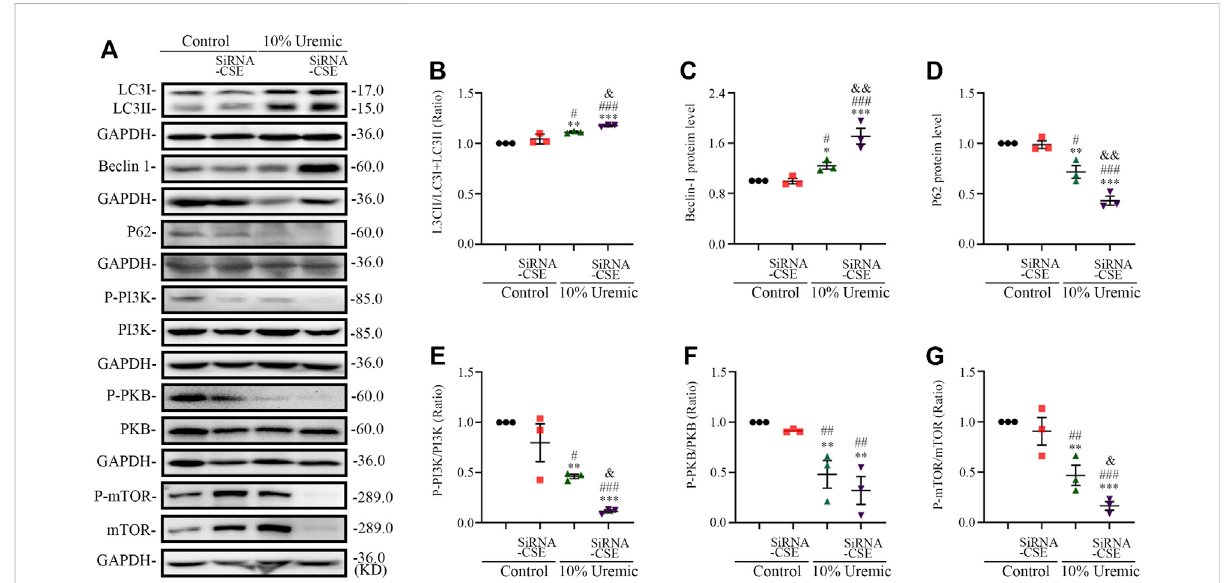
FIGURE 6 Endogenous H 2 S de fi ciency exacerbates uremic serum-induced overactive autophagy in H9C2 cardiomyocytes. (A) Representative Western blot images of LC3, becline-1, P62, p-PI3K/PI3K, p-PKB/PKB, and p-mTOR/mTOR in four groups of H9C2 cardiomyocytes. (B – D) Quanti fi cation of the LC3II/LC3 (I + II) ratio, becline-1 protein levels, and p62 protein levels in the four groups of H9C2 cardiomyocytes, with n = 3 per group. (E – G) Quanti fi cation of p-PI3K/PI3K, p-PKB/PKB, and p-mTOR/mTOR in four groups of H9C2 cardiomyocytes, with n = 3 per group. Data are represented as Mean ± SEM. * p < 0.05, ** p < 0.01, *** p < 0.001 vs. control group; # p < 0.05, ## p < 0.01, ### p < 0.001 vs. 10% control + SiRNA-CSE group; & p < 0.05, && p < 0.01 vs. 10% uremic serum + SiRNA-CSE